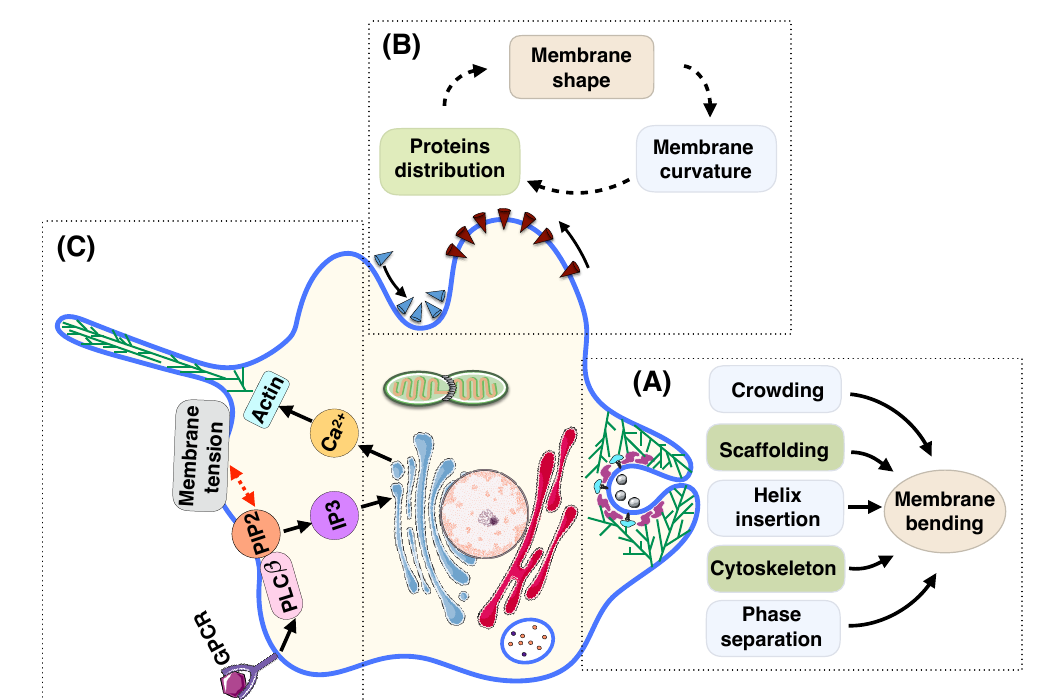
Figure 5. Perspective for the future of theoretical models for membrane curvature generating mechanisms. ( A ) Various mechanisms are involved in trafficking including amphipathic helix insertion into the bilayer, protein scaffolding, cargo-receptor crowding, forces from actin polymerization, and lipid phase separation [236,237]. ( B ) The coupling between membrane shape, membrane curvature, and membrane proteins distribution. The convex proteins (indicated with red cones) aggregate and flow toward the hill where the membrane curvature is negative (assuming the normal vector to the surface is outward). On the other hand, the concave proteins (represented by blue cones) accumulate and move toward the valley where the membrane curvature is large and positive [176]. ( C ) The coupling between the formation of a filopodial protrusion and the intracellular signaling inside the cell [238]. The ligand attachment to the G-protein-coupled receptor (GPCR) activates isotype β of the phospholipase C (PLC β ) which is a class of membrane-associated enzymes. PLC β stimulates the phosphatidylinositol 4,5–bisphosphate (PIP2) which is a phospholipid component of the cell membrane and regulates the membrane tension. The hydrolysis of PIP2 produces the messenger molecule inositol trisphosphate (IP3). Binding IP3 molecules to the ER releases the calcium (Ca 2 + ) that stored in the ER to the cytoplasm. The Ca 2 + is a key intracellular molecule that controls the actin polymerization at the leading edge of the membrane